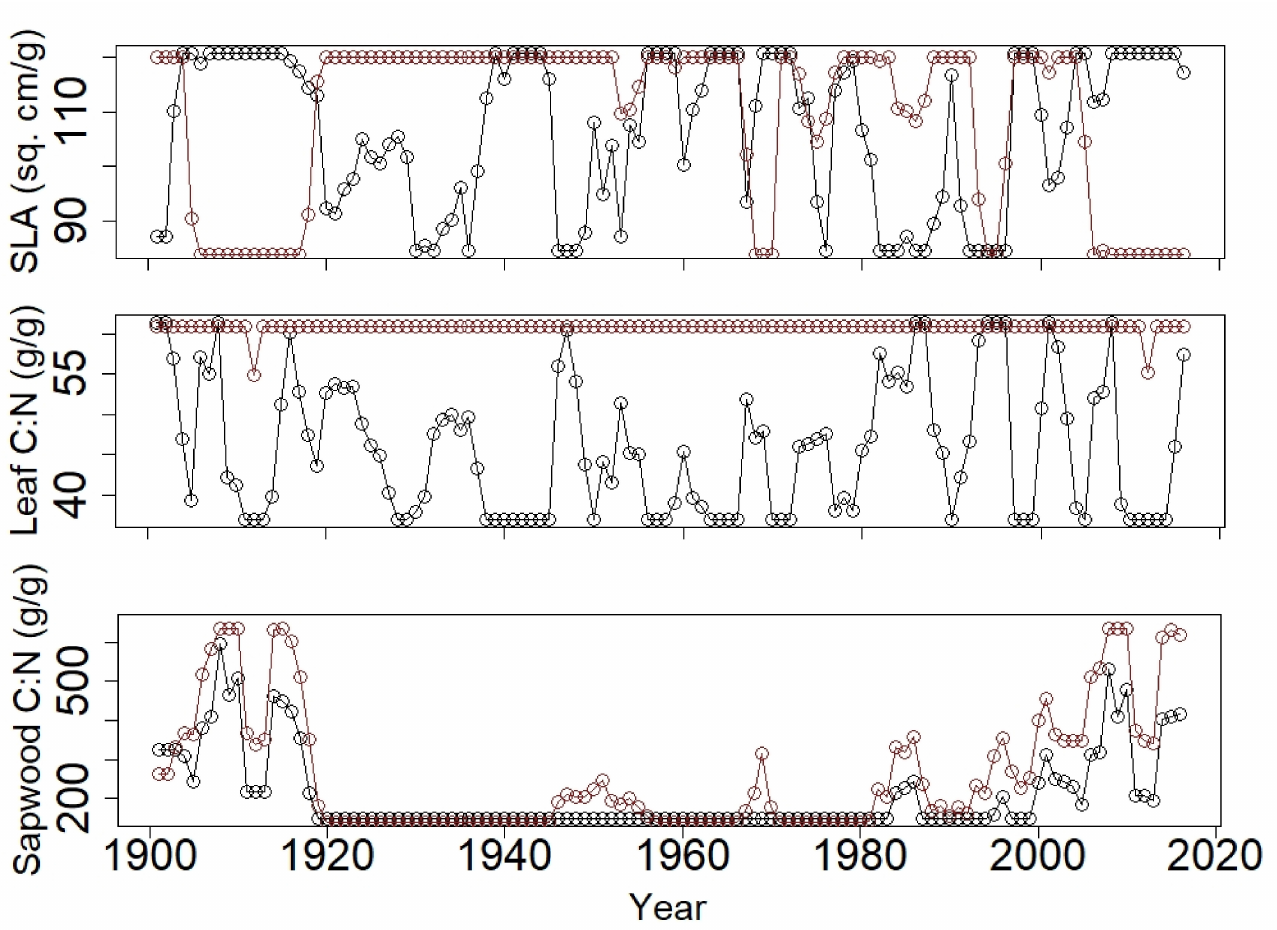
Figure 5. Evolution in the course of the years of the predicted specific leaf area (SLA), leaf C:N and sapwood C:N, over the pixel of two sampling locations (black: Middle Atlas #9, brown: Rif